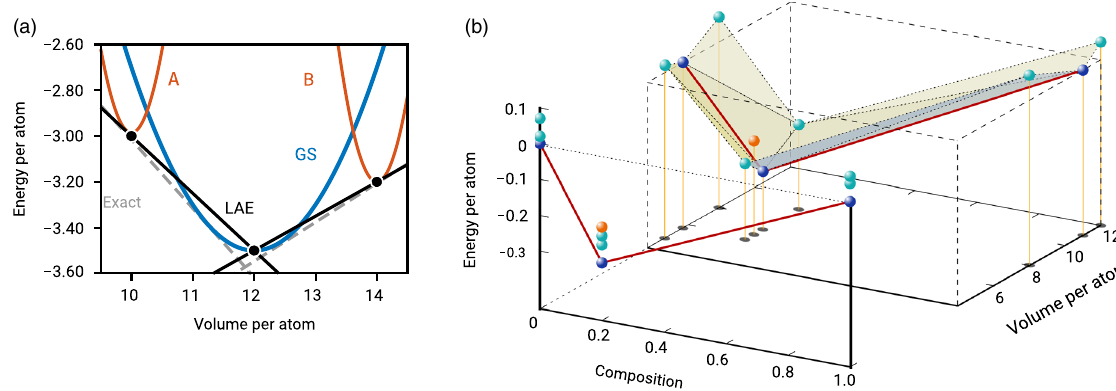
FIG. 1. (a) A schematic energy-volume ( E – V ) diagram with three phases [the ground state (GS), and two metastable phases A and B] and their EOS, each represented by a parabola. The negative slope of the common tangent to two adjacent EOS (dashed grey lines) represents the pressure at which the two phases are in equilibrium. The LAE approximates the common tangent with a line connecting the ambient-condition equilibrium volumes and energies of two adjacent phases (solid black line connecting filled circles). (b) A schematic N – V – E convex hull for a model binary system. Individual phases are represented by spheres, and convex hull boundaries are indicated with solid red and dotted black lines. On the left is the conventional zero-pressure N – E hull, a projection of the extended N – V – E convex hull on the right. Phases that are thermodynamically stable at zero pressure lie on the N – E convex hull (blue spheres). Metastable phases that are stable at some nonambient pressure lie above the N – E hull but on the N – V – E convex hull (teal spheres). A phase that is truly unstable at any pressure lies above the N – V – E hull (orange